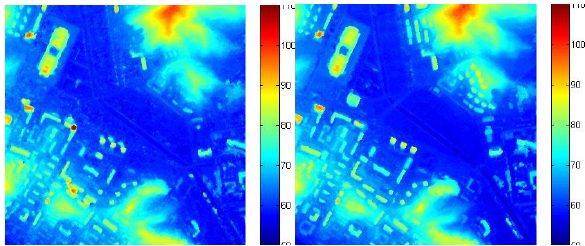
Figure 8: DSMs from the scenes of 2006 (left) 2010 (right), both sections 1000 m × 1000 m, color coded heights in m mask; true negatives (TN): black, pixels detected unchanged and also unchanged in reference; false positives (FP): red, unchanged pixels found erroneously as changes by the algorithm; false nega-